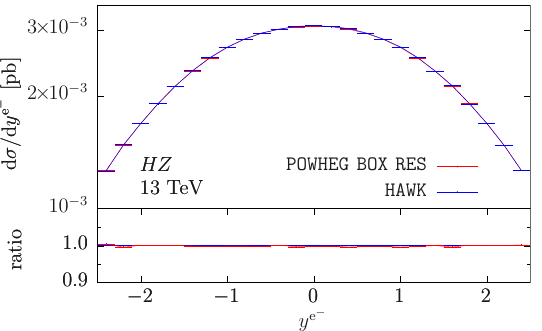
Figure 31. NLO EW predictions for the rapidity of the electron. Same curves and labels as in (cid:12)gure